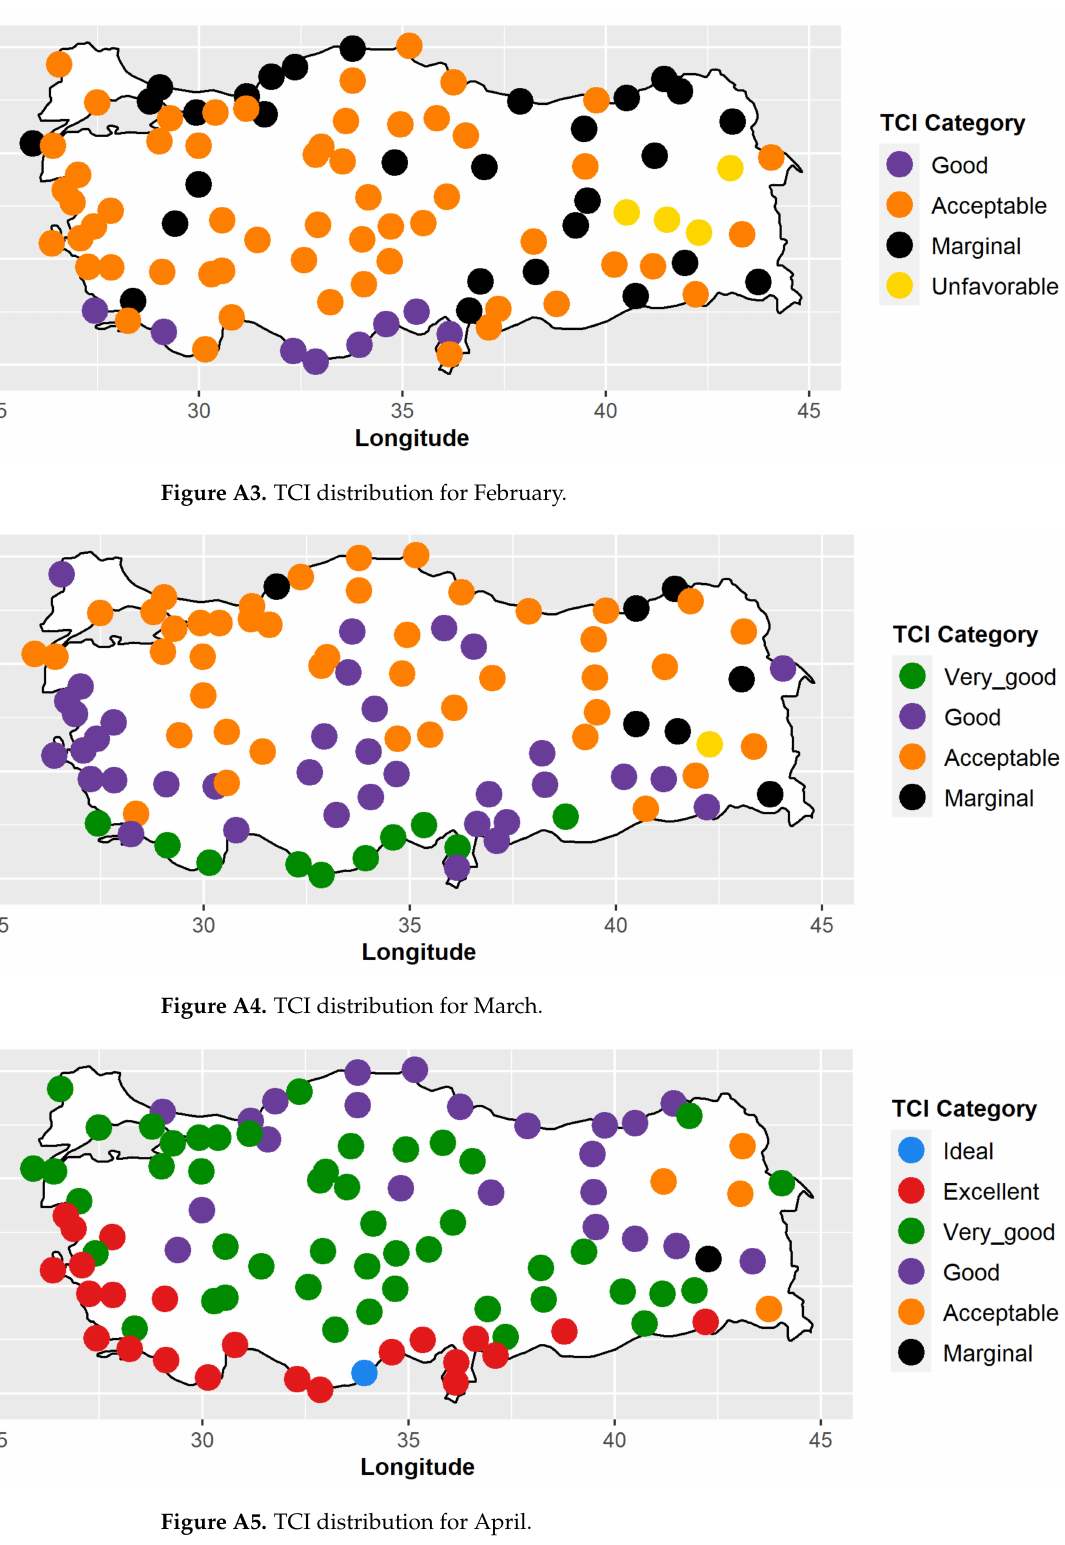
Figure A5. TCI distribution for